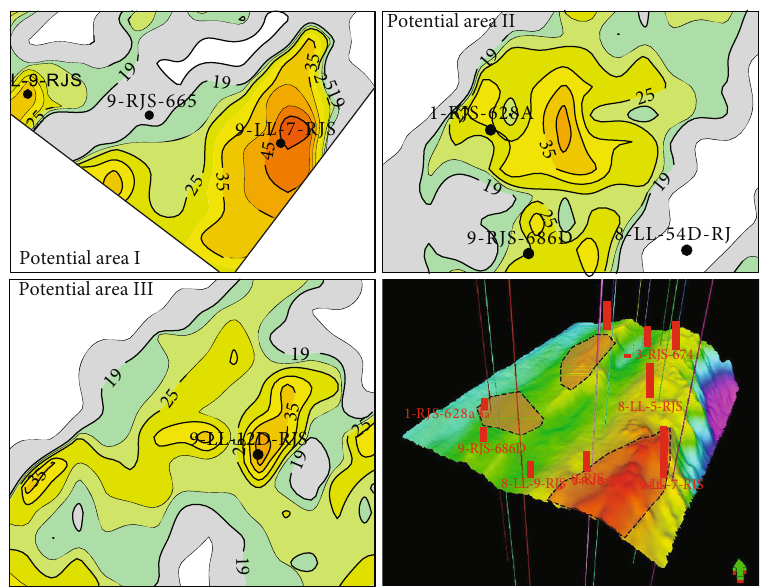
Figure 20: The results of the integrated prediction of the potential area